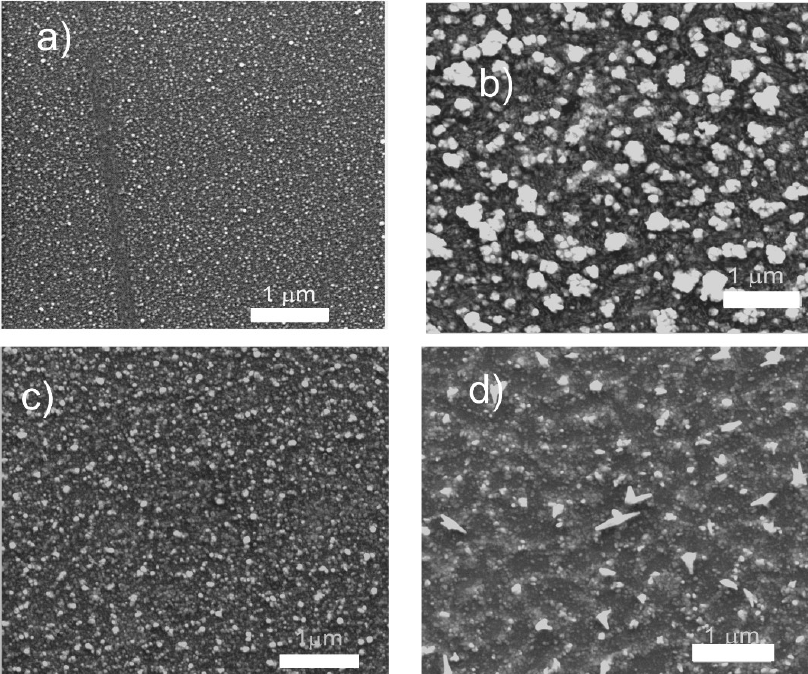
S thin films annealed in a nitrogen-sulfur atmosphere at a) 25°C, b) 250°C, c) 300°C and c) 350°C, 2 3